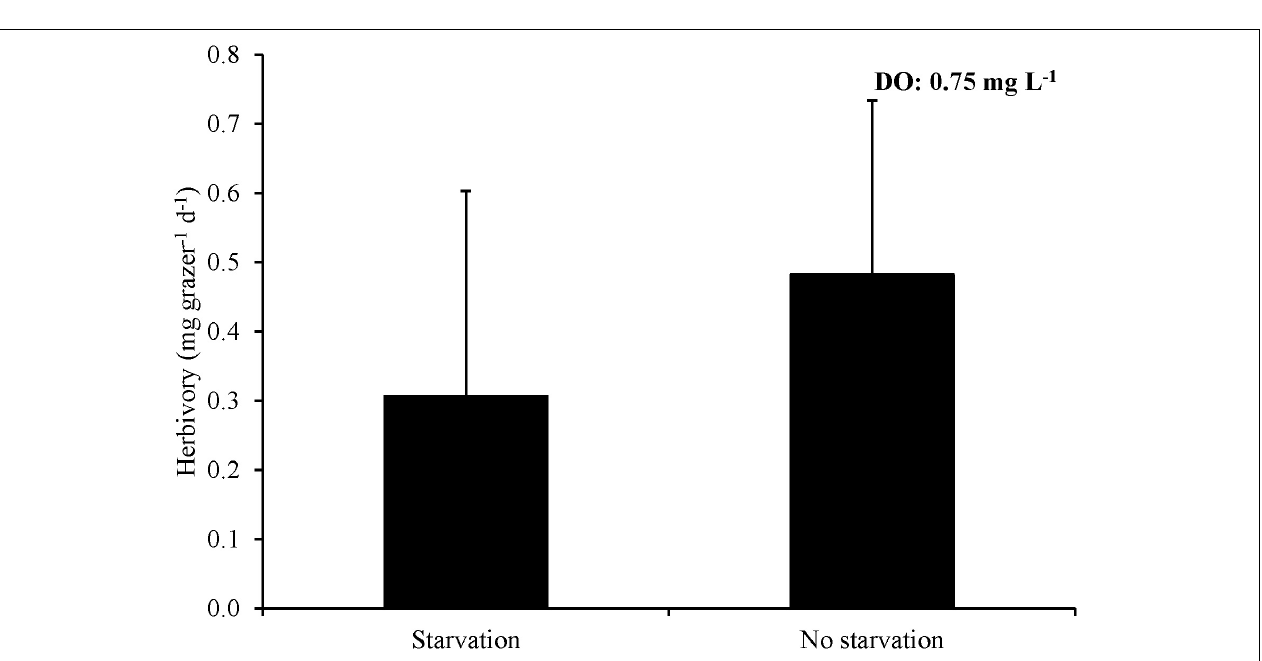
FIGURE 9 | Herbivory rates of L. vincta either starved or not starved for 24 h under ambient DO and then allowed to graze on U . rigida for 3 h under low DO concentrations (0.75 mg L − 1 ) (Experiment 9; Table 2 ).